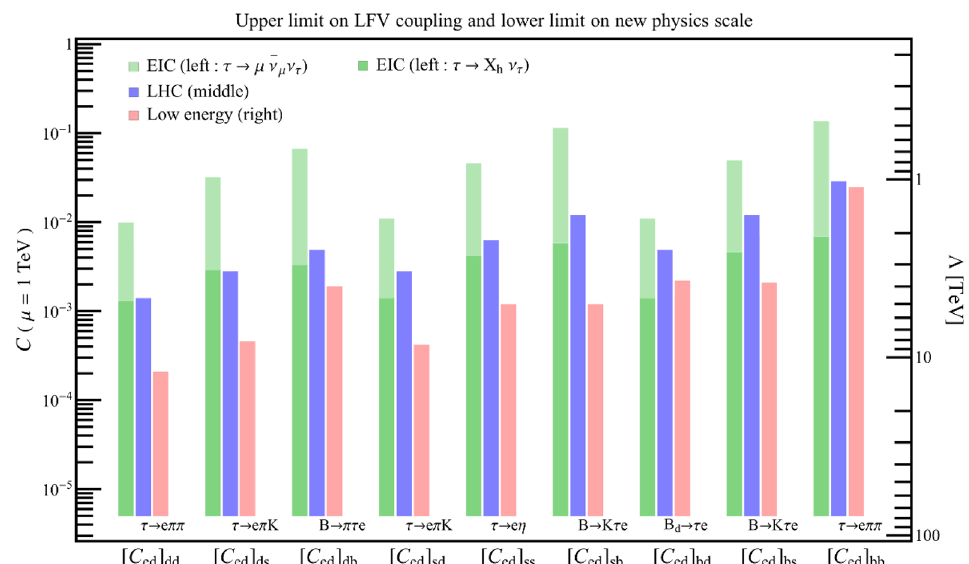
Figure 17 . Upper limit on C ed (leftmost axis) and lower limit on new physics scale Λ (rightmost axis). For the EIC expected sensitivity, the light green bar corresponds to the result in table 7, while the dark green one represents the case in hadronic tau decay mode assuming (cid:15) n b = 0 in tables 3–5.